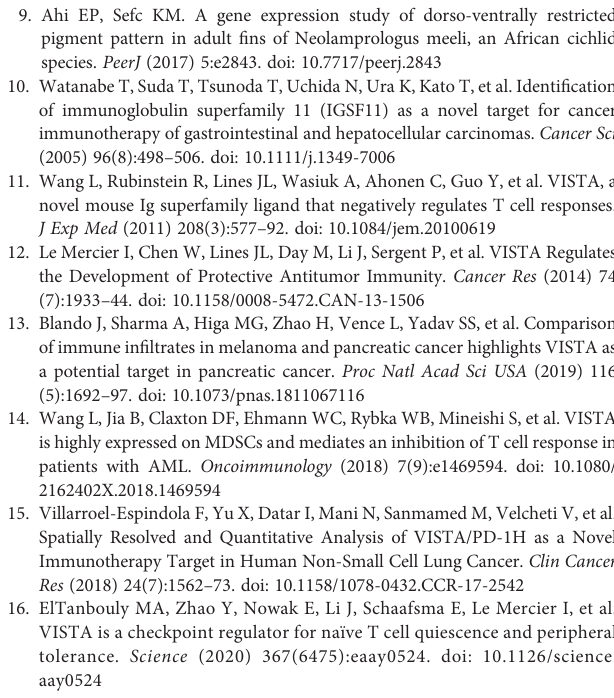
Supplementary Figure 1 | Anti-CD3 antibody coating is unaffected by mixing in VSIG3 protein as determined by VSIG3 inhibited cytokine production by PBMCs. (A) The biotinylated anti-human CD3 antibody (1 m g/mL) and different concentrations of human VSIG3 protein were coated on 96-well fl at bottom plates at 4°C for 16 hours. Binding of biotinylated anti-human CD3 was detected by adding streptavidin-HRP followed by substrate color reagents. 1×10 5 PBMCs were stimulated with plate-bound anti-CD3 antibody in the presence of VSIG3 or control- IgG at a ratio of 1:2 (1 µg/ml CD3 and 2 µg/ml VSIG3 or control-Ig), 1:5, 1:10, 1:20. Culture supernatants were collected at 48 h, and the level of IFN- g (B) and TNF- a (C) was analyzed by ELISA. Representative results from three independent experiments are shown. Supplementary Figure 2 | VSIG-3bindstoVISTAbyELISA. (A) TheVISTAprotein neutralizes the inhibitory effect of VSIG3 protein expressed by CHO cells on PBMCs activation. Exogenous VISTA was incubated with VSIG3 coated on 96-well plate, and then PBMCs were added. The expression levels of IFN- g and TNF- a in PBMCs were evaluated with ELISA. *p<0.05, **p<0.01, ***p<0.001 and ****p<0.0001 vs. control. (B) Human VSIG3-ECD expressed by CHO cells speci fi cally binds to recombinant VISTA in a functional ELISA binding assay. (C) Different concentrations of VSIG3 antibody inhibited the binding of VSIG3/VISTA. Representative results from three independent experiments are shown. Supplementary Table 1 | Candidate compound binding rate to VSIG3